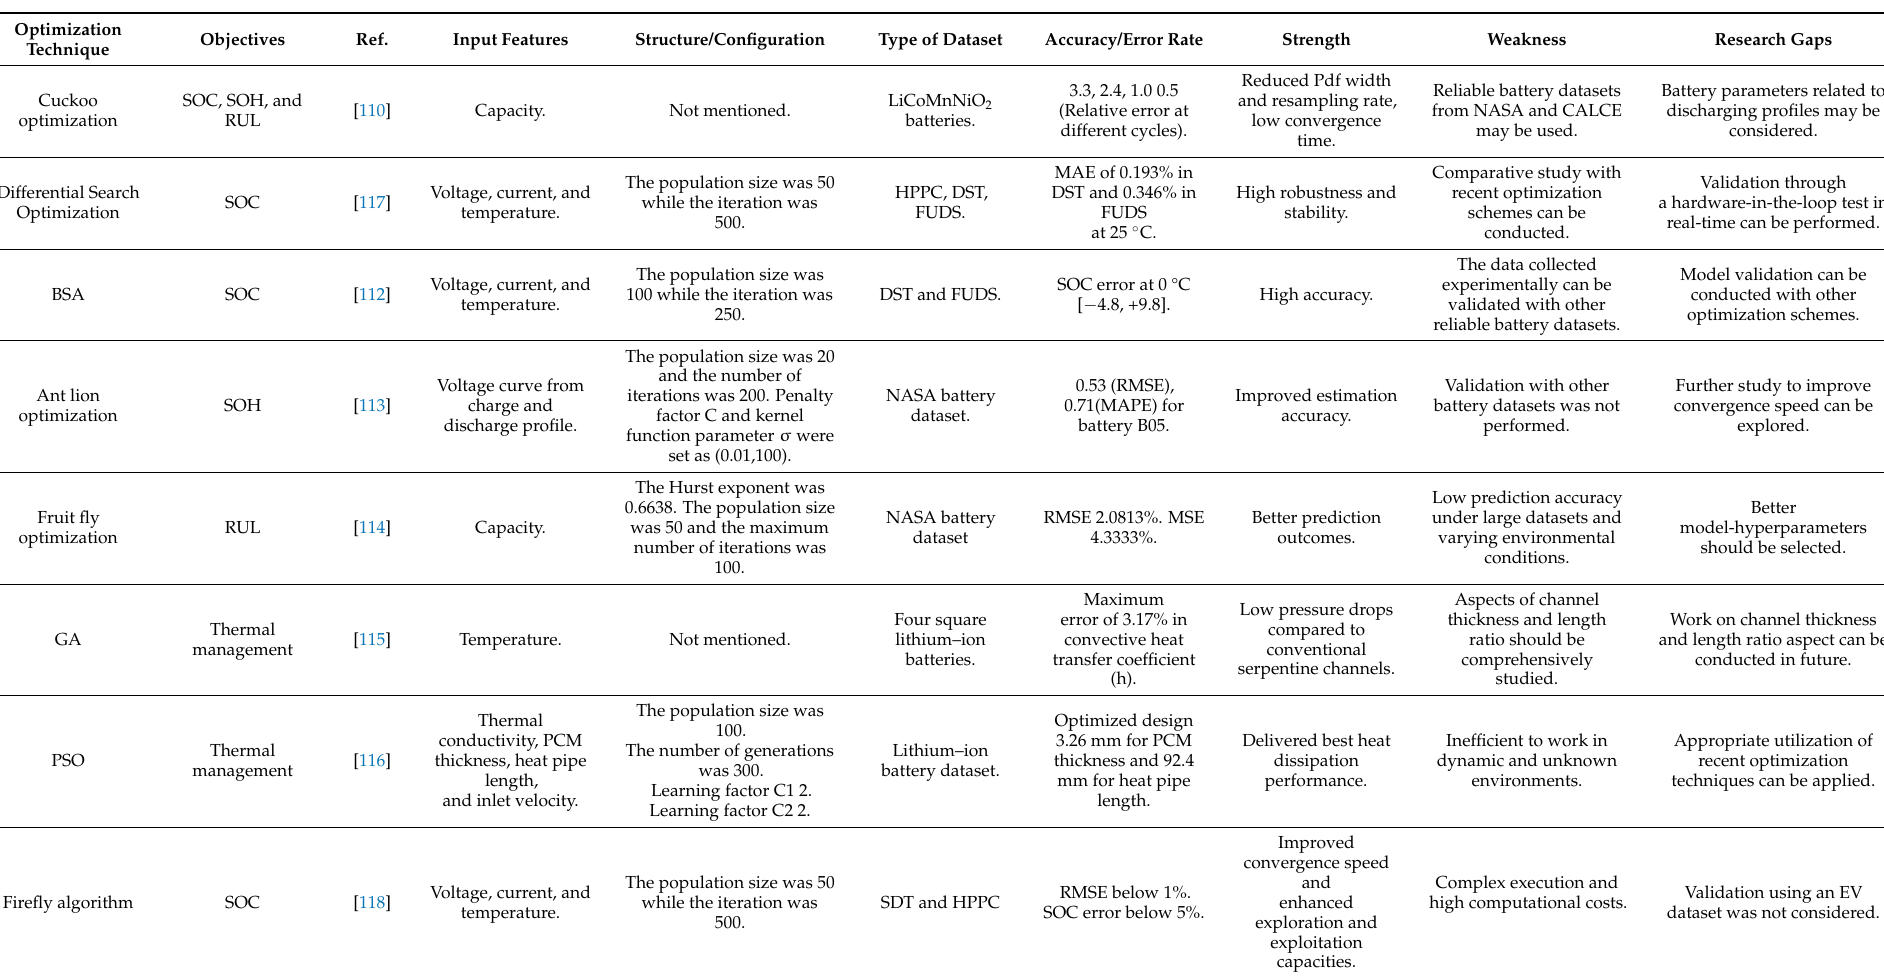
Table 6. Optimization approaches for BMS in EV